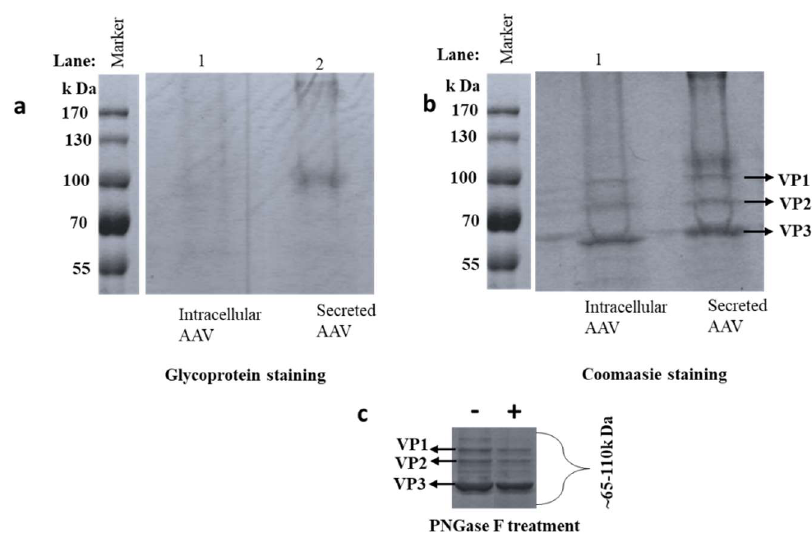
Figure 2. AAV8 Glycosylation detection. AAV8 derived from the cell (intracellular), and media (secreted) are separated on SDS-PAGE ( a ) protein bands visualized after glycoprotein staining. Glycosylated bands were observed near the AAV8 capsid protein (VP) region (55–100 kDa). Gel ( b ) is gel ( a ) stained with Coomassie brilliant blue to visualize the whole protein profile. ( c ) Independent Coomassie stained gel run after de-N- glycosylation of secreted sample. (+ and − the addition of PNGase F).